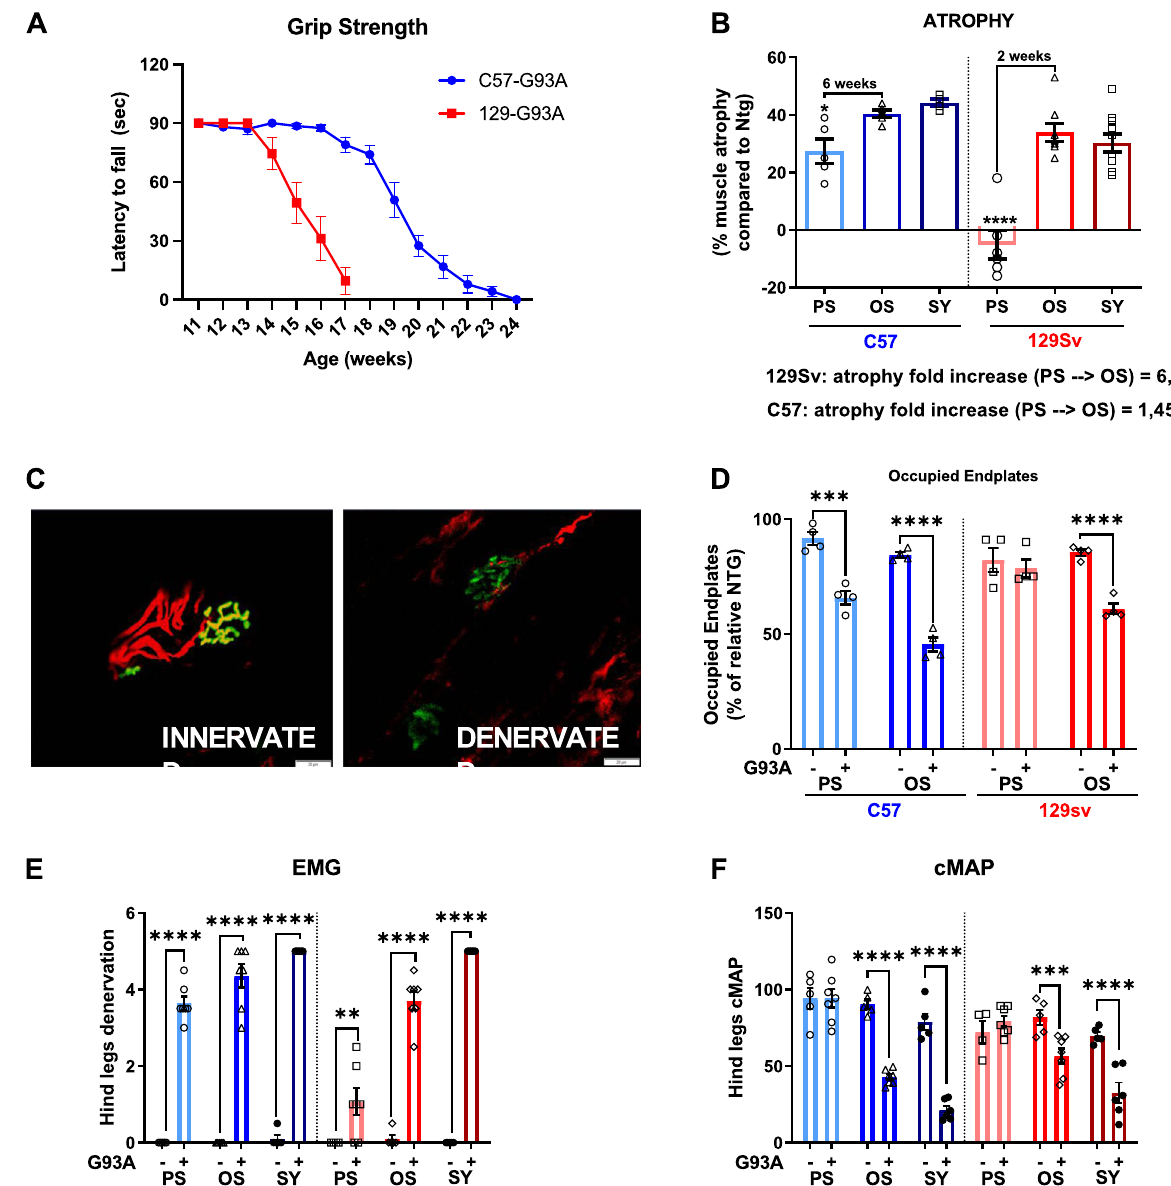
Fig. 1 Skeletal muscle denervation atrophy in fast- and slow-progressing SOD1 G93A mice. A Paw grip endurance (PaGE) test for 129SvSOD1 G93A mice and C57SOD1 G93A mice. The data are reported as mean SEM for each time point ( n 10 mice per group). B Muscle mass was calculated by ± = measure of gastrocnemius (GCM) muscles weight of 129SvSOD1 G93A mice; C57SOD1 G93A mice and NTG littermates at different time points of the disease ( n 4–10). Percent muscle atrophy was calculated relative to NTG mice at PS and OS. Data are reported as mean SEM. Significance was = ± calculated with 2-way ANOVA with uncorrected Fisher’s LSD post-analysis (* p 0.05, **** p 0.0001). C and D Representative confocal micrographs ≤ ≤ and analysis of innervated endplates. α-Bungarotoxin (BTX, green) was used to identify the postsynaptic domain; SV2/2H3 (red) were used to identify presynaptic terminals (scale bar: 50μm). D Percentage of innervated endplates. Data are reported as mean SEM (~no. 100 BTX-positive ± endplates per animal were randomly chosen and analysed) ( n 4). Significance was calculated with 2-way ANOVA with uncorrected Fisher’s LSD = post-analysis (*** p 0.001, **** p 0.0001). E and F Electromyography on hindlimb muscles of C57SOD1 G93A mice and 129SvSOD1 G93A mice and ≤ ≤ NTG littermates at PS, OS, and SY. Denervation ( E ) and compound muscle action potential (cMAP) ( F ) through a coaxial electrode were evaluated. Data are reported as mean SEM. Significance was calculated with 2-way ANOVA with uncorrected Fisher’s LSD post-analysis and RM-ANOVA (* p ± ≤ 0.05, ** p 0.01, *** ≤ ≤